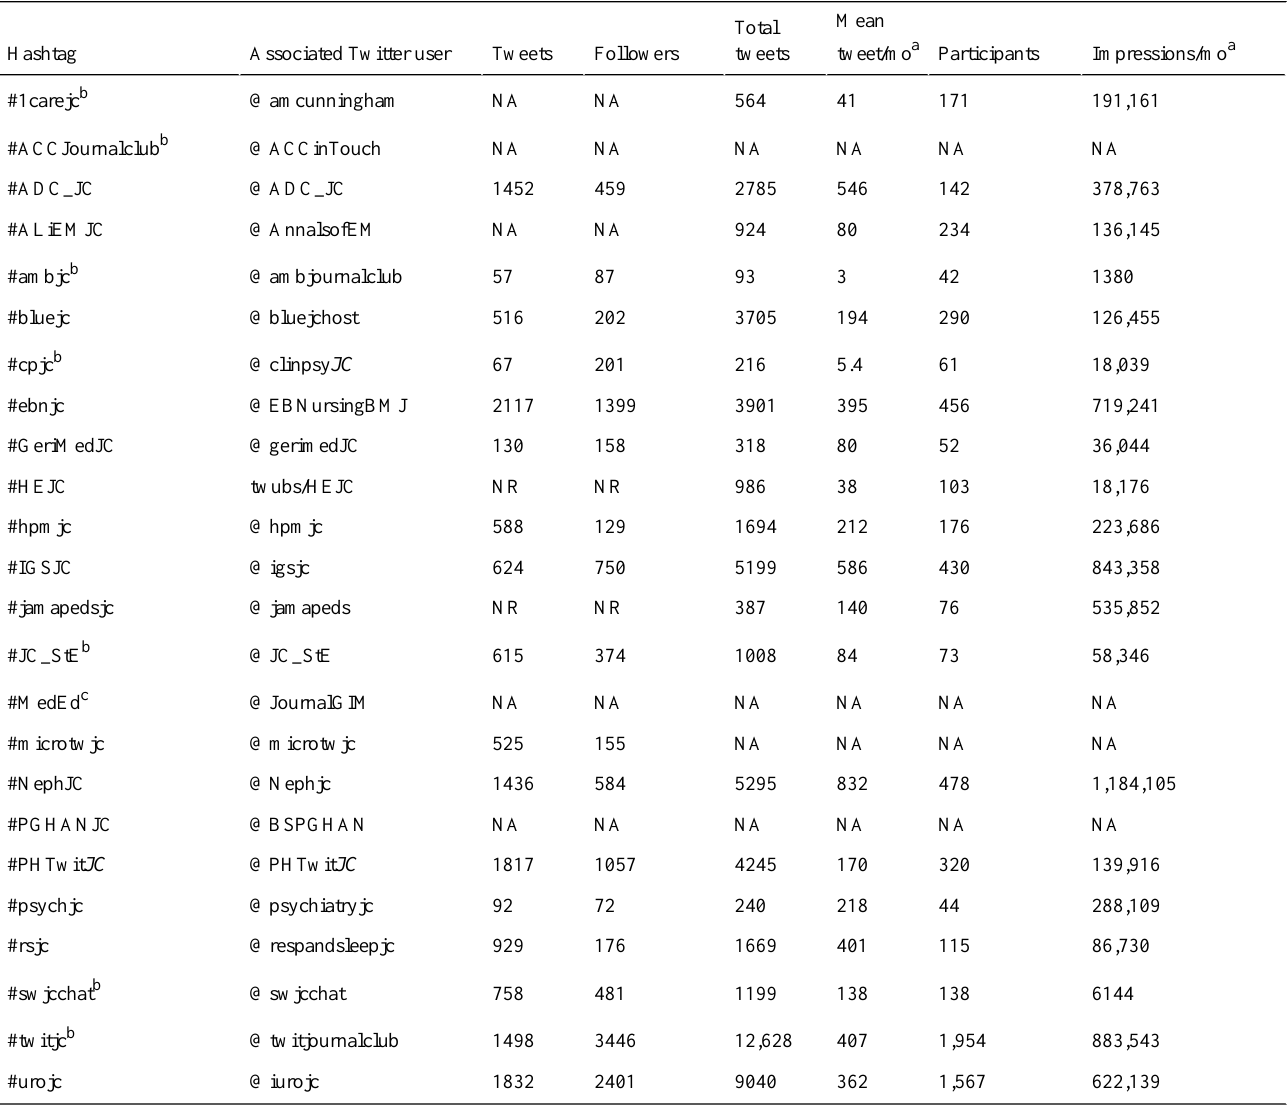
Table 2. Twitter-based journal club performance, incorporating standard metrics such as tweets and followers, as well as overall tweets, participants and impressions, with calculated monthly mean tweets and impressions relating to each journal club as defined by Symplur . tweetsFollowersTweetsAssociated Twitter